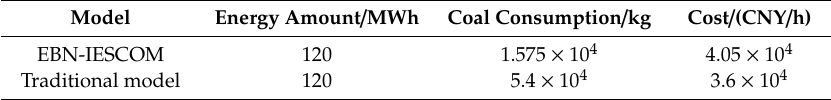
Table 9. Simulation results of energy consumption and cost in